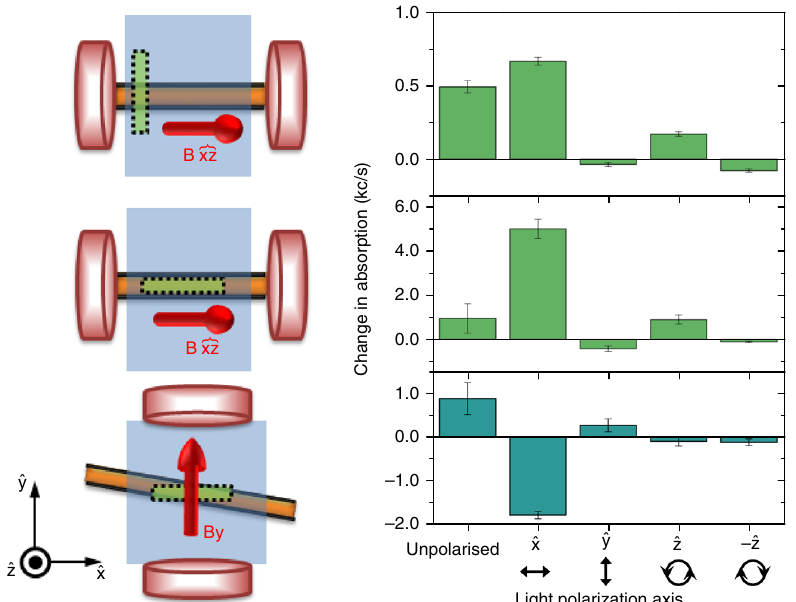
Fig. 3 Effect of light polarization on optical absorbance. Schematic representations show the magnet (red), waveguide (orange), sample (blue) and measured area (green). top, A fi eld is applied in the ^ X direction with an out of plane component (~10% B in the ^ z axis). Spin pumping leads to an improved absorbance light polarized in the ^ X and þ ^ Z directions and reduced absorbance for ^ Y and (cid:2) ^ Z . The effect is maximized when we probe only the fi lm top of the waveguide (middle). bottom, If we alter the sample geometry and apply a magnetic fi eld in the ^ Y direction, with the waveguide at an angle, the effect in polarization is reversed, with higher absorbance in the y axis and reduced for the x axis. Change in absorbance for unpolarized light is, as expected, smaller in the top when monitoring in/outside the waveguide and equal in the middle and bottom con fi gurations. Error bars are the standard error of the mean in averages of the optical absorbance over 70 points in a 100 × 300 μ m